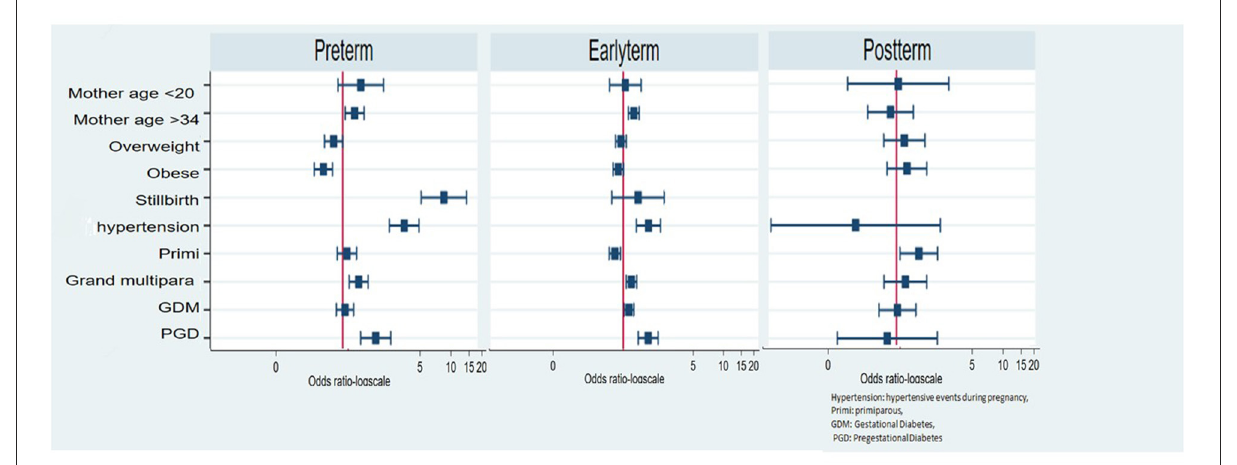
FIGURE1 Independent effects of maternal and fetal factors on the gestational age at